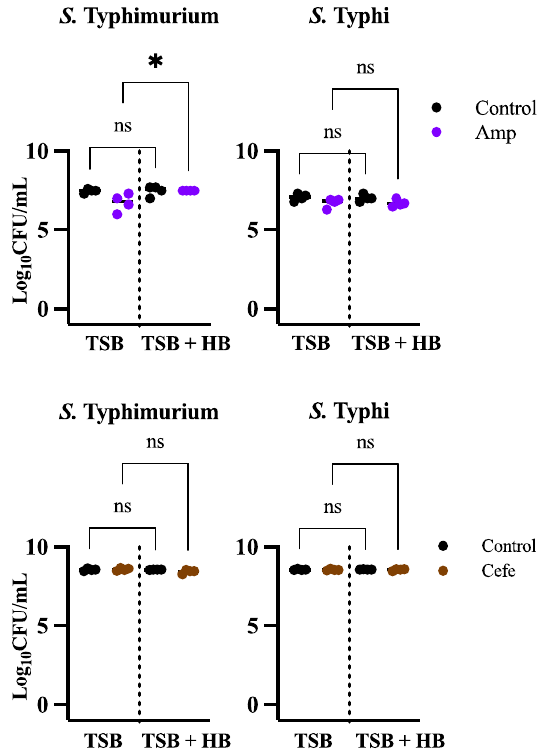
Figure 4. Persister cells recovered in S . Typhimurium 14028 and S . Typhi Ty2 laboratory strains after treatment with ampicillin (purple circles) or cefepime (orange circles) in biofilms growing in human bile (HB) versus total cells (strains not treated with antibiotics are represented by black cir- cles). Representative charts are shown from one experiment performed with four or more biological replicates and repeated at least three times with similar results. A one-way ANOVA followed by Tukey’s multiple-comparison test were used to compare the different conditions (ns, not significant; *, p ≤ 0.05).